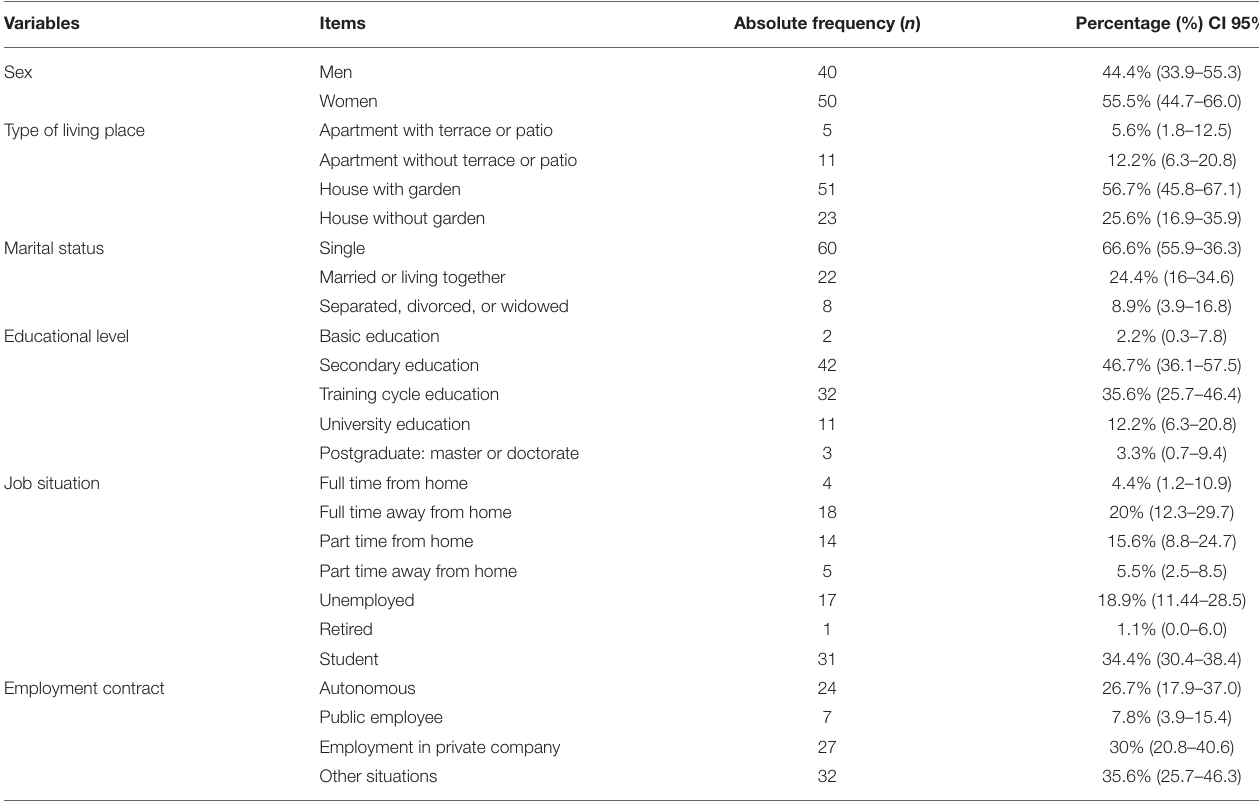
TABLE 1 | Sociodemographic results of the sample.